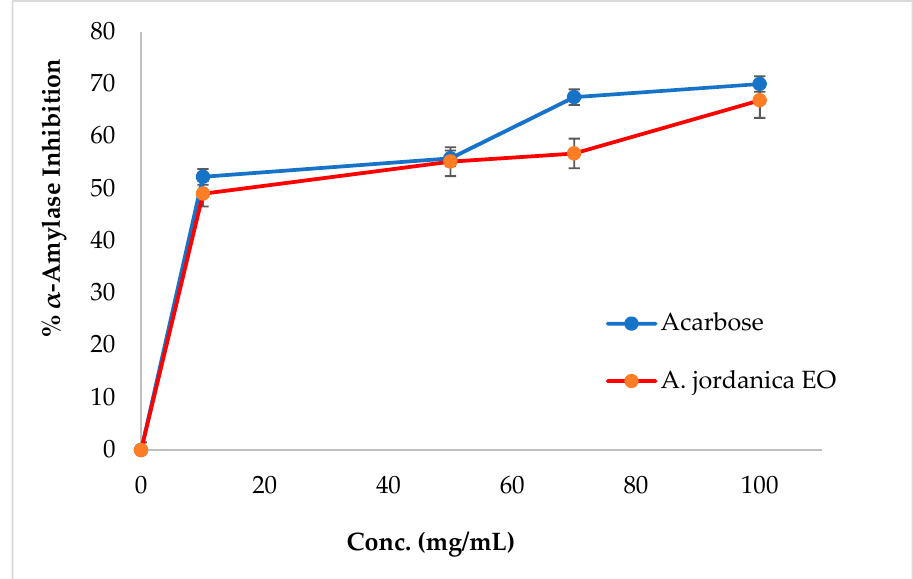
Figure 4. α -Amylase inhibitory activity by Artemisia jordanica essential oil and acarbose.